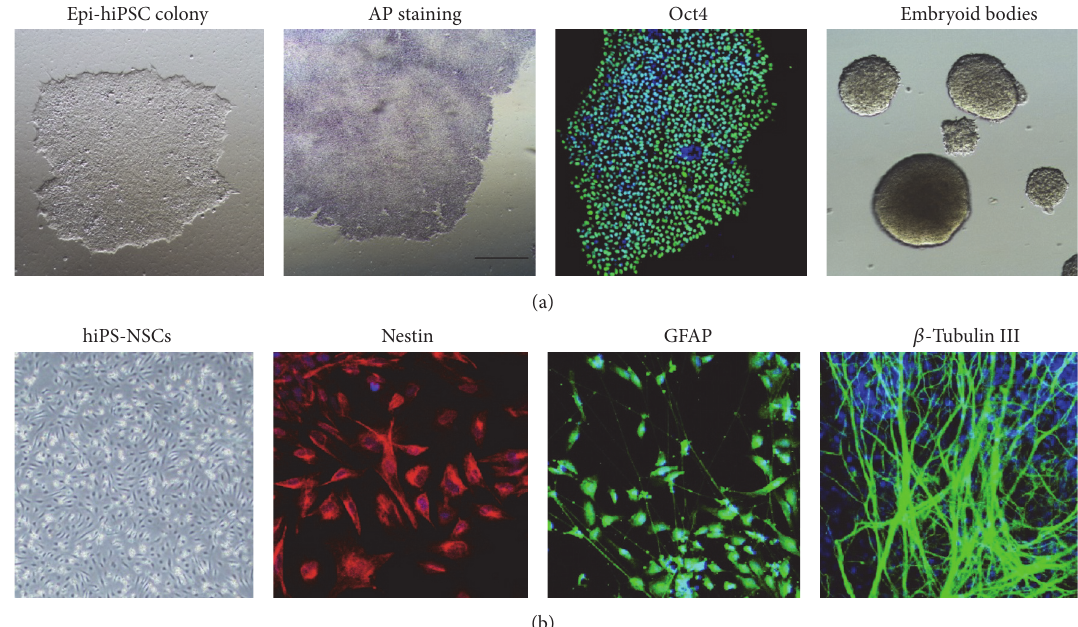
Figure 1: Deviation of NSCs from an epi-hiPSC line. (a) Characterization of an epi-hiPSC line generated with nonintegrating episomal vectors.Fromlefttoright:colonymorphology,APstaining,immunostainingofOct4,andembryoidbodydifferentiation.(b)Characterization and in vitro neural differentiation of hiPS-NSCs. From left to right: bipolar cell morphology, immunostaining of nestin (NSC early stage marker), GFAP (astrocyte marker), and 𝛽 -tubulin III (neuron